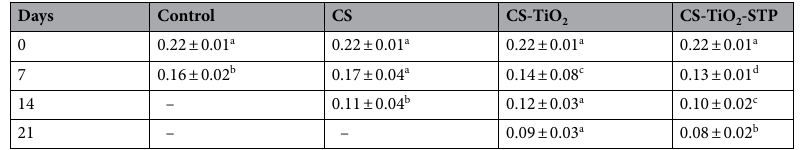
Table 1. Effect of coating treatments of cucumber samples on SDH activity (∆OD min −1 mg protein −1 ). * Values within a column (lowercase) are significantly different (p ≥ 0.05). The values in parentheses indicate (SD±) standard deviation. (Control) refers to the treatment with distilled water, CS is the (Chitosan), CS-TiO 2 is Chitosan/Titanium Dioxide Nanoparticles, while CS-TiO 2 -STP is (Chitosan/Titanium Dioxide Nanoparticles/Sodium